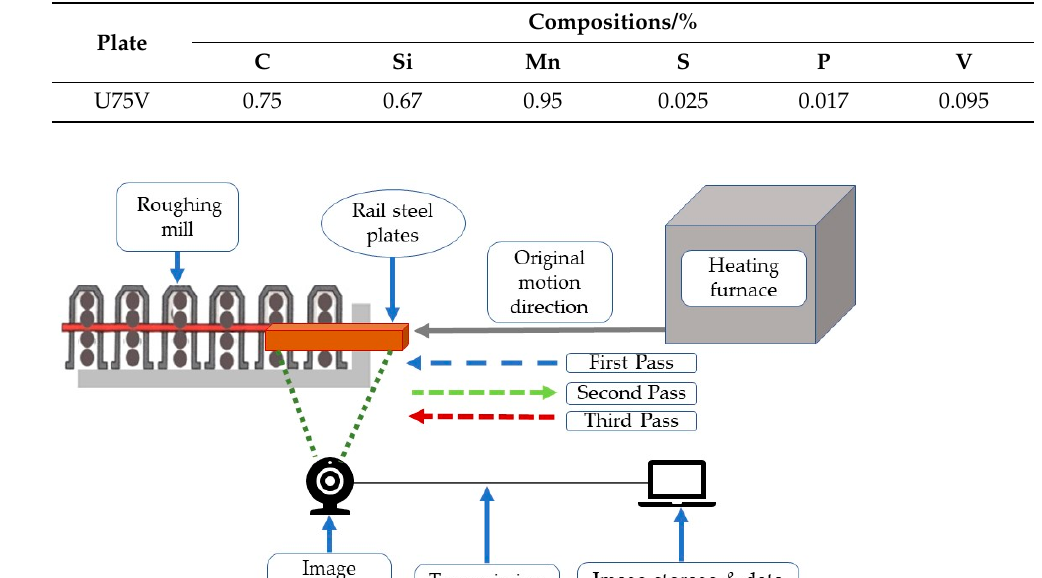
Table 2. The main compositions of the U75V rail steel plates.